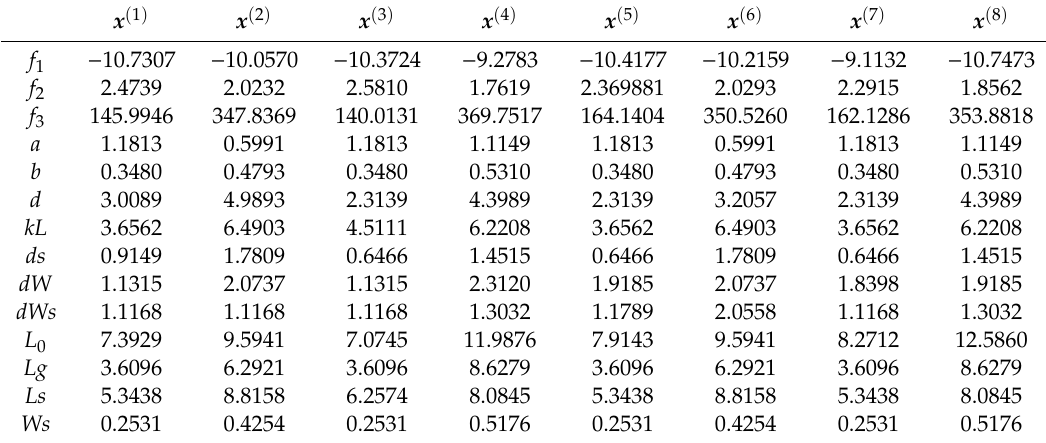
Table 2. Objective values and parameter values of selected designs found by